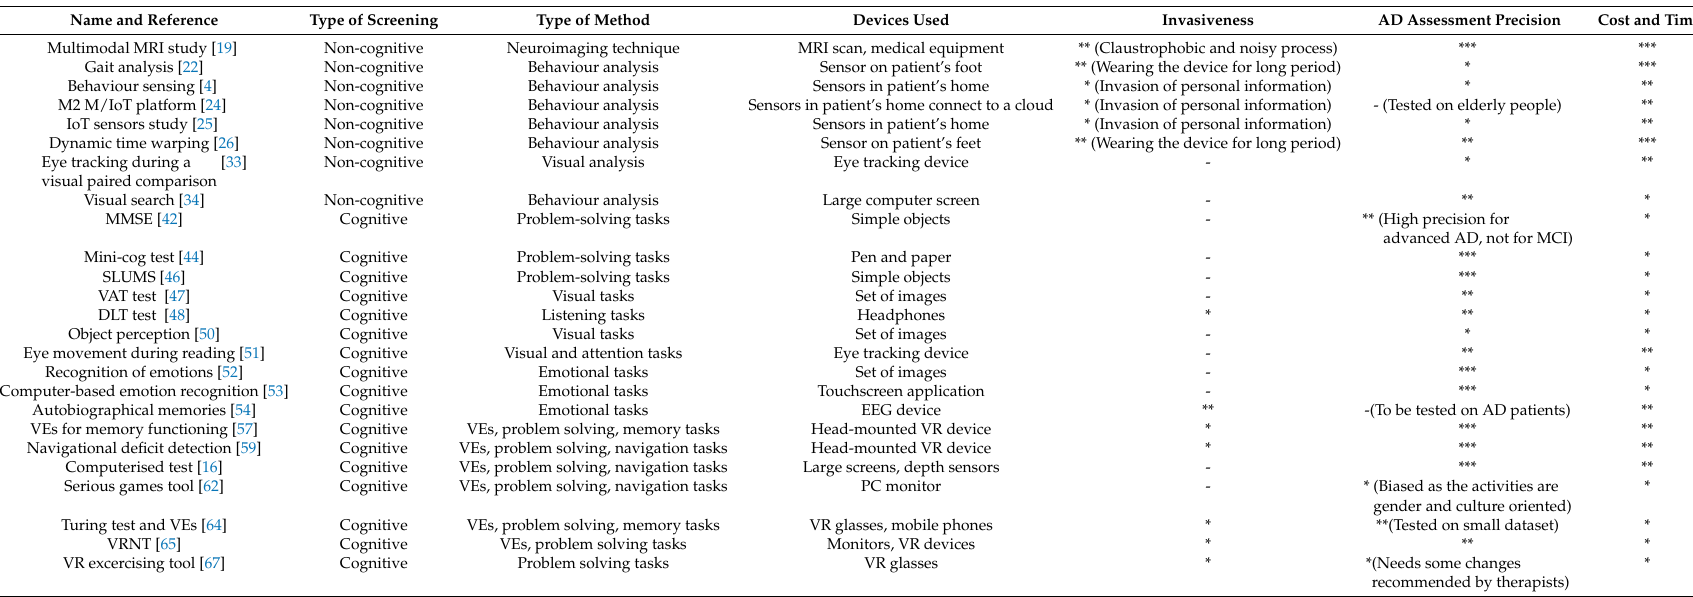
Table 1. Summary of AD screening methods. The classification is rated with one to three stars (*) and a mark (-) if it is not